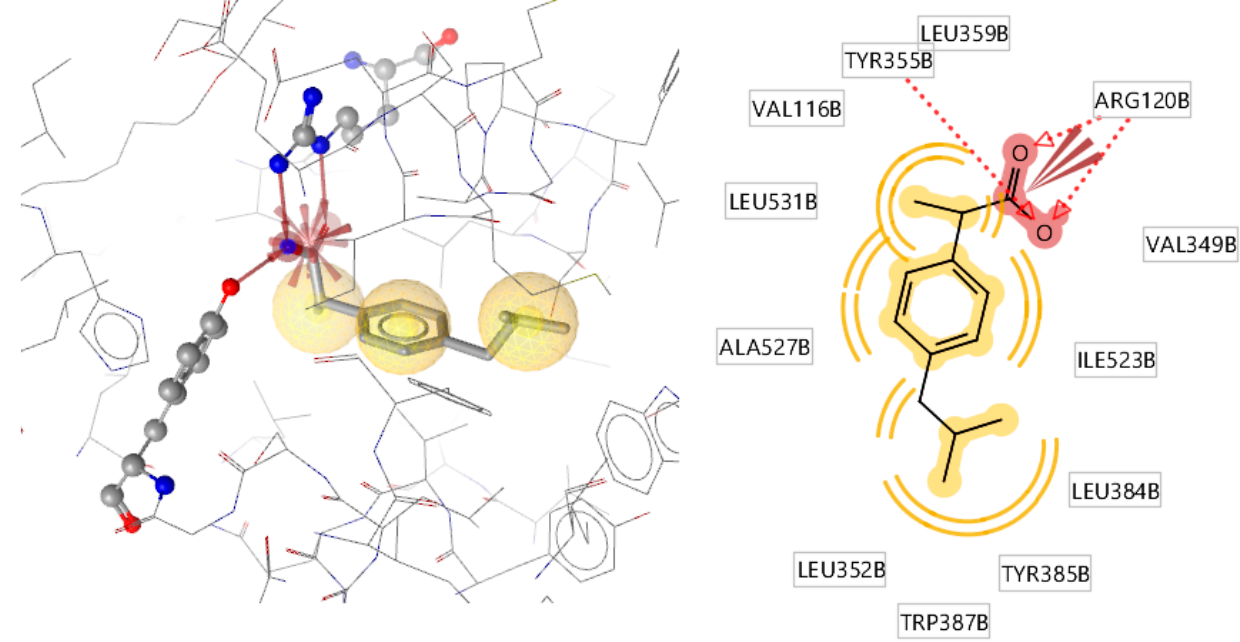
Figure 4. Docking pose of co-crystallized ligand, ibuprofen (S) (IBF), in the COX-1 active site. Red dotted arrows indicate H-bond and yellow spheres indicate hydrophobic interactions.